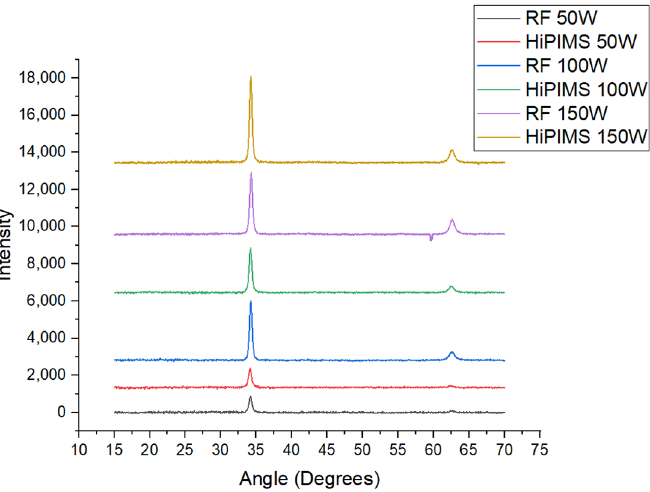
Figure 2. XRD diffractogram results displaying both the RF and HiPIMS depositions.